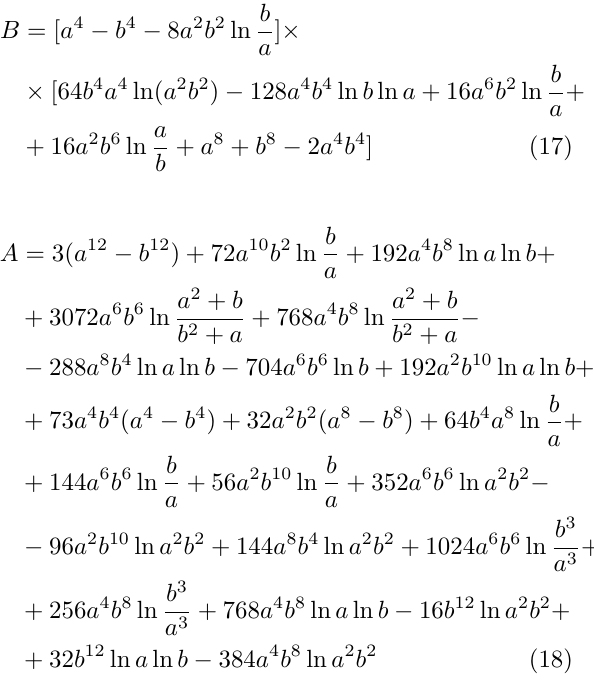
in drilling with and da